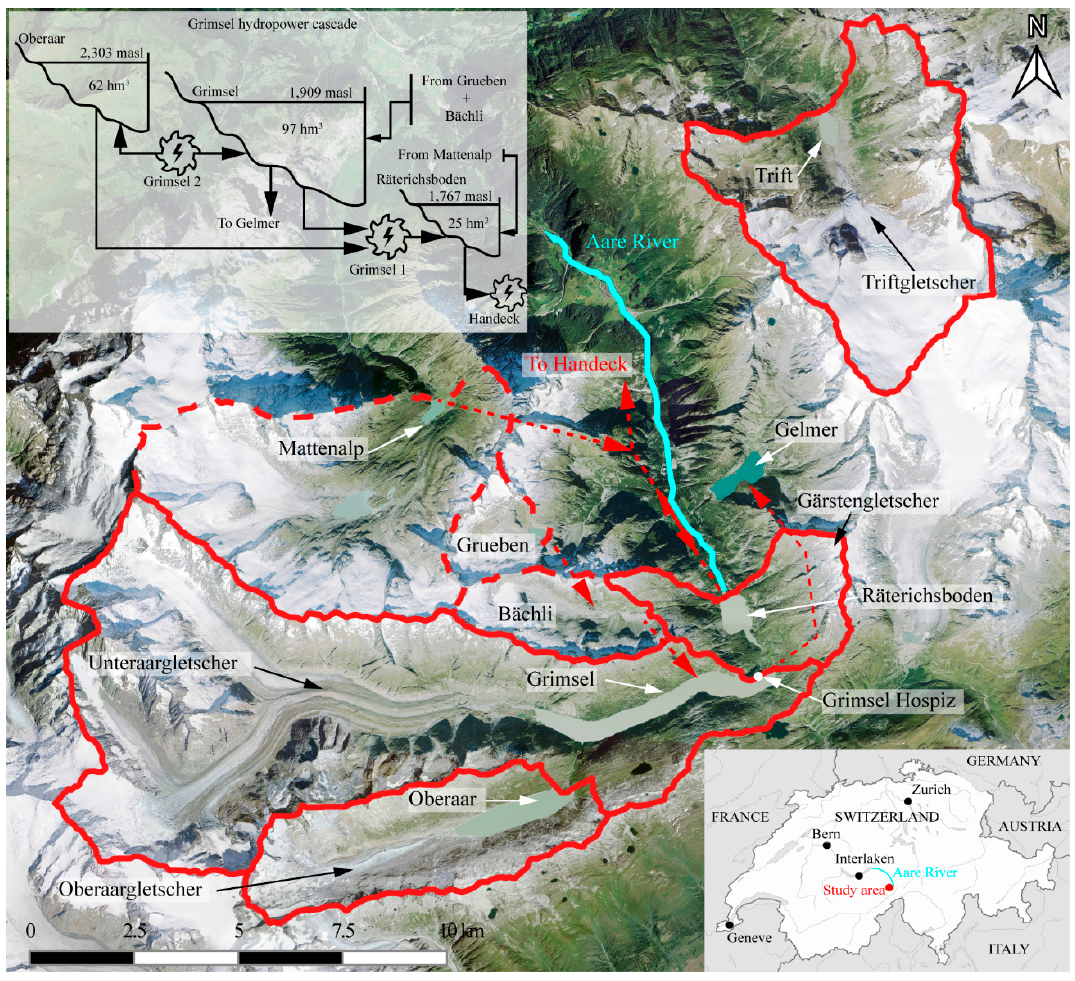
Figure 1. Aerial view of the catchments analyzed and operating diagram of the Grimsel hydropower cascade. (Background image: www.swisstopo.ch).